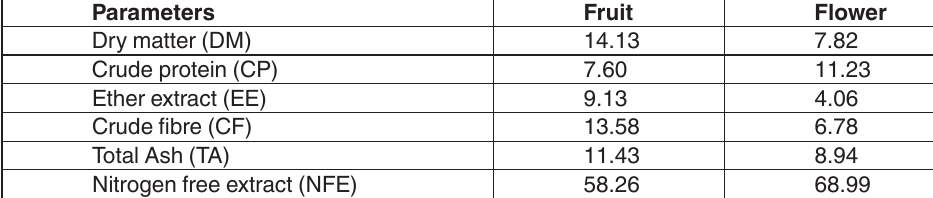
table 3: Body weight (g) and dry matter intake (g) of experimental rats